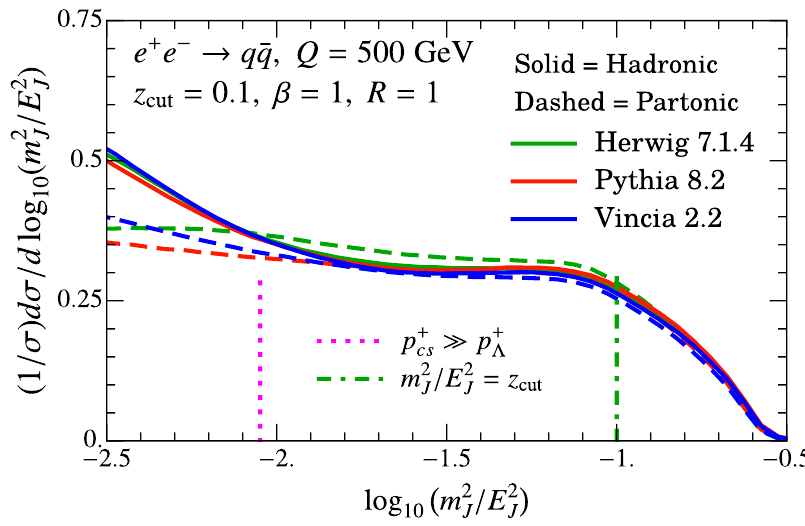
Figure 20 . Di(cid:11)ering hadronization models and partonic cross sections in Monte Carlos in the soft drop operator expansion region.